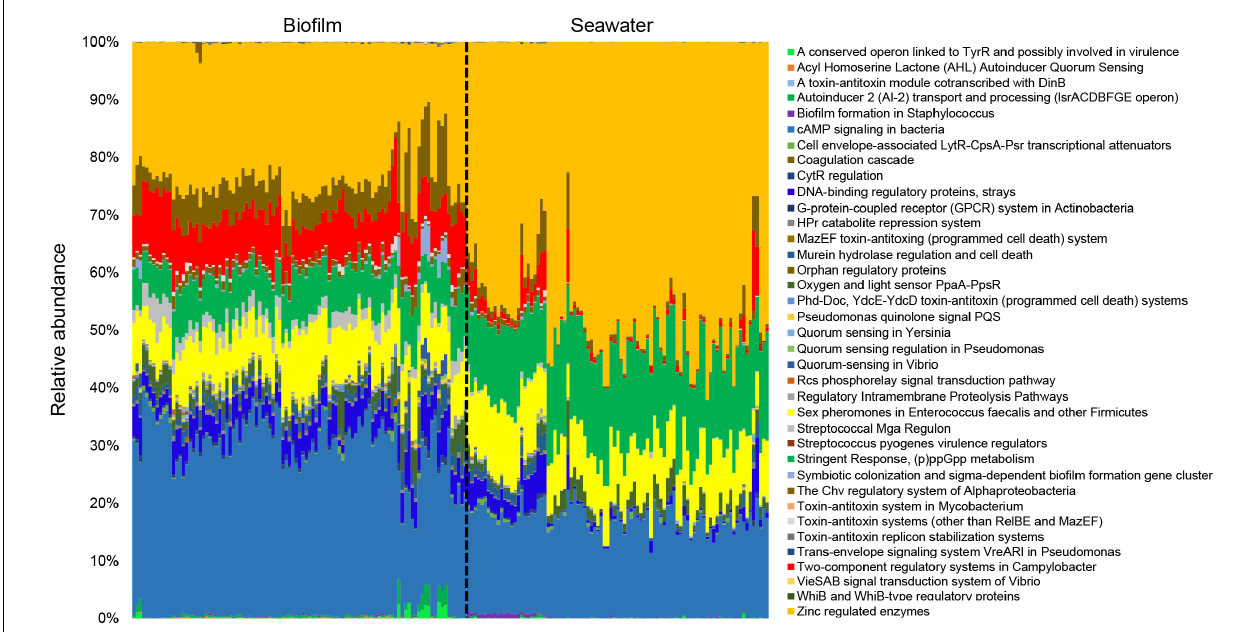
FIGURE 1 | Overall profiles of signal transduction genes in 101 marine biofilm and 91 seawater samples. The biofilms were collected in eight different locations around the world oceans. The relative abundance of different SEED functional categories (SEED2 level) that are related to microbial signal transduction is given. All the metagenomes were normalized to equal data size (i.e., 10,000,000 reads per metagenome) before performing the analysis.